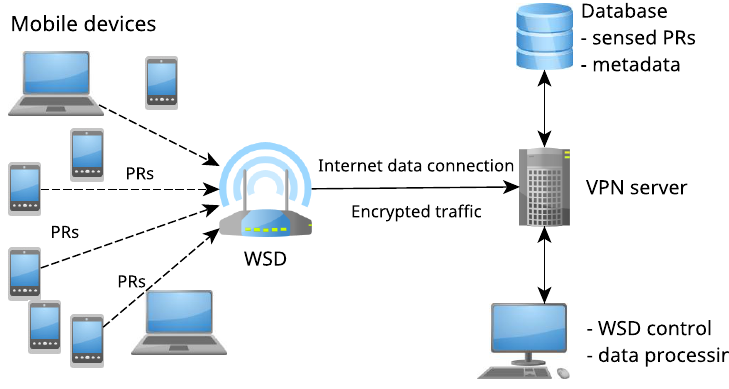
Figure 2. Schematic of system design and flow of